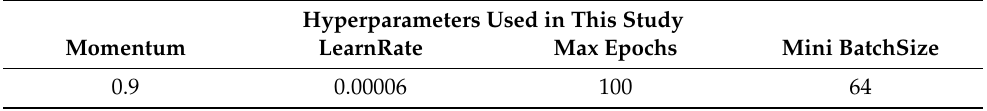
Table 3. The hyperparameter settings used in this